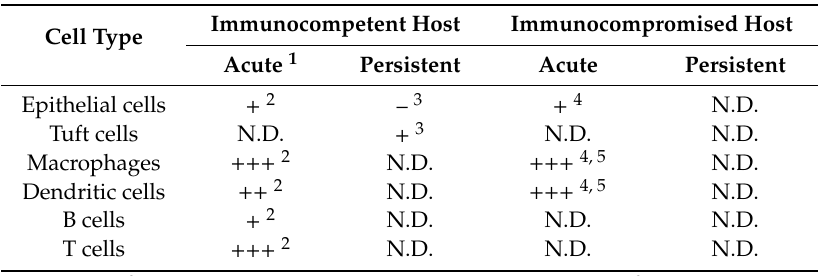
Table 1. In vivo cellular tropism of murine norovirus